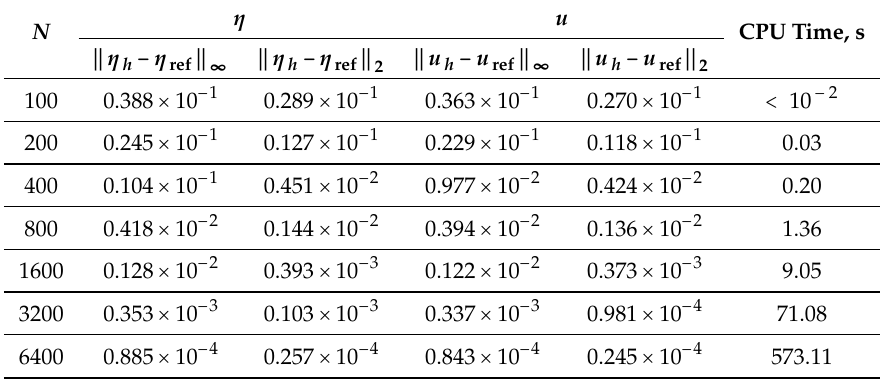
Table 5. The numerical solution errors measured at the final simulation time t = T f on a fixed grid. The reference solution is given be Equations (25) and (27). All numerical parameters for this simulation are reported in Table 4.